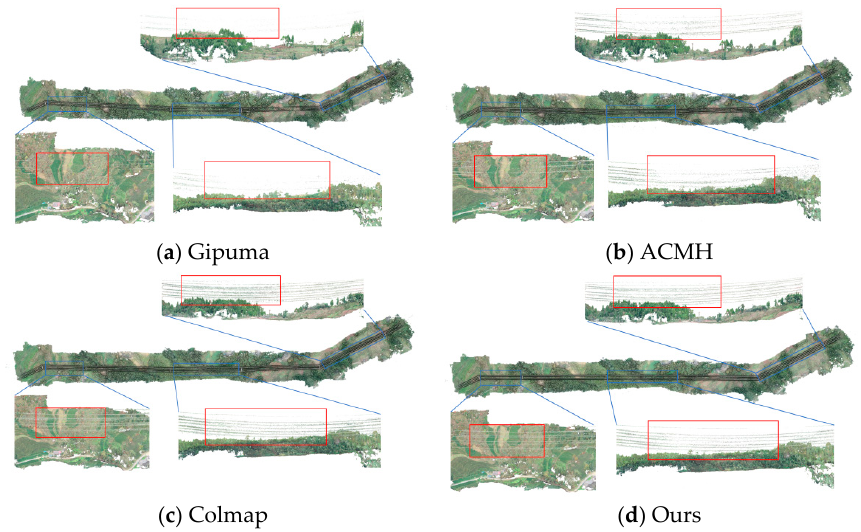
Figure 7. The comparison of reconstructed point clouds of power lines in test site 1. ( a – d ) are generated by Gipuma, ACMH, Colmap, and the proposed method, respectively. The two sides of test side 2 are hillsides, while the middle part is low, with a large height difference between both sides. Figure 8 is the results of the reconstructed power lines with different methods. From Figure 8, it can be seen that Gipuma can only recon- struct a few of the power lines on both sides of the span; while the ACMH can reconstruct relatively more complete point clouds of power lines than Gipuma, but in the middle re- gion, parts of power line cannot be reconstructed; Colmap and the proposed method re- construct power lines more completely than ACMH and Gipuma.